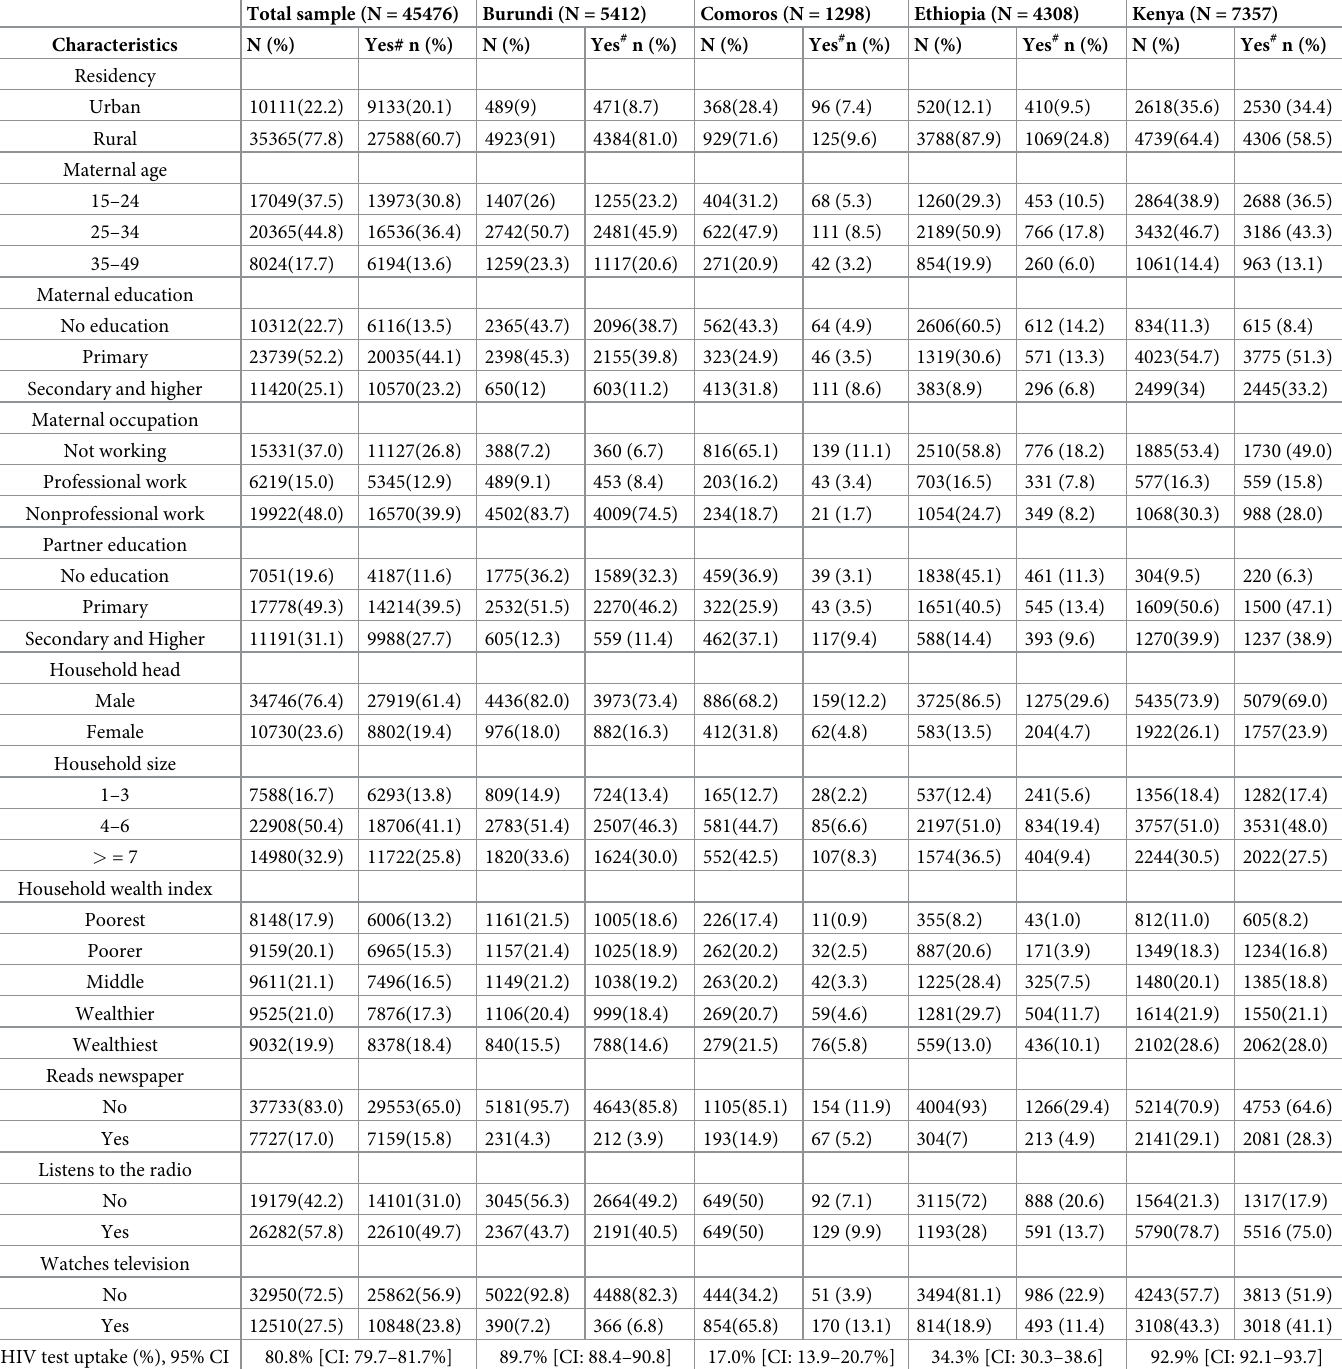
Table 1. Study participant characteristics and percentage of prenatal HIV test service users for PMTCT by study factors in East African countries (N = 45,476; Demographic and Health Survey,